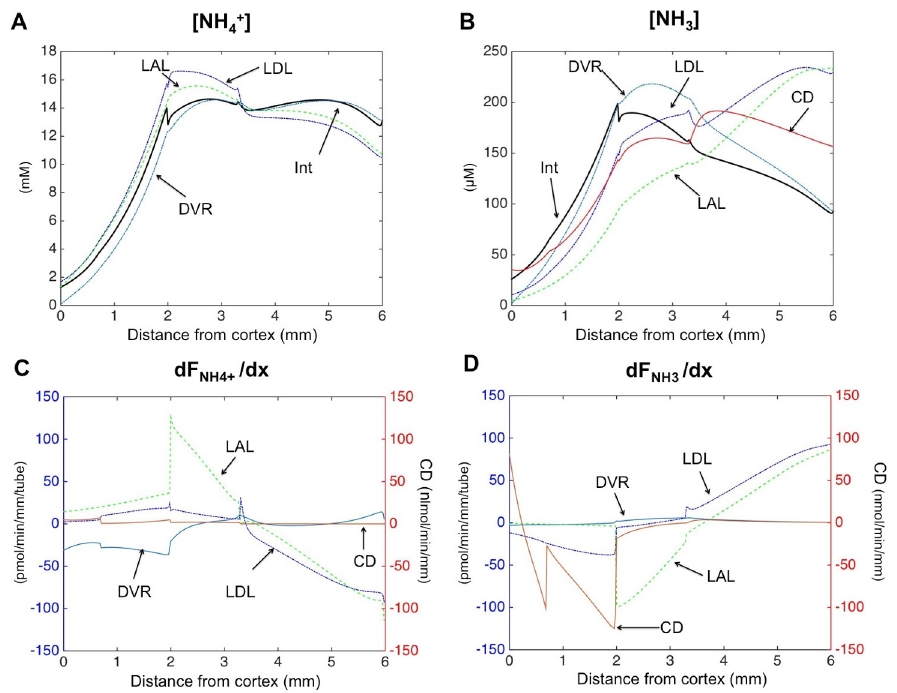
Fig 4. Model results: (A-B) NH þ 4 and NH 3 concentration pro fi les. In the outer medulla, passive diffusion gradients favor secretion of NH 3 into nephron segments and reabsorption of NH þ transmural fl uxes pro fi les. Positive fl uxes denote absorption, whereas negative fl uxes represent secretion. Please note the different scales for total fl uxes in the collecting ducts (nmol.min -1 mm -1 ), whereas fl uxes are given per tube in nephron segments and blood vessels (pmol.min -1 mm -1 .tube -1 ).